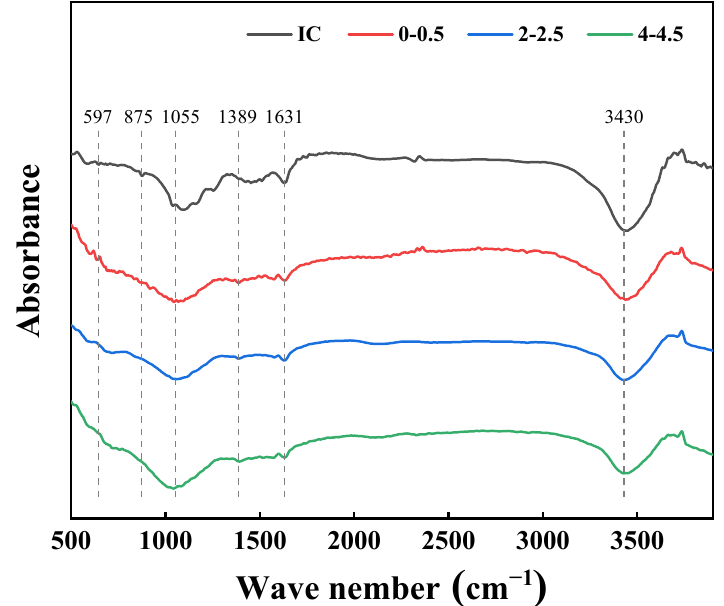
Figure 13. Infrared spectra of IC and TC.